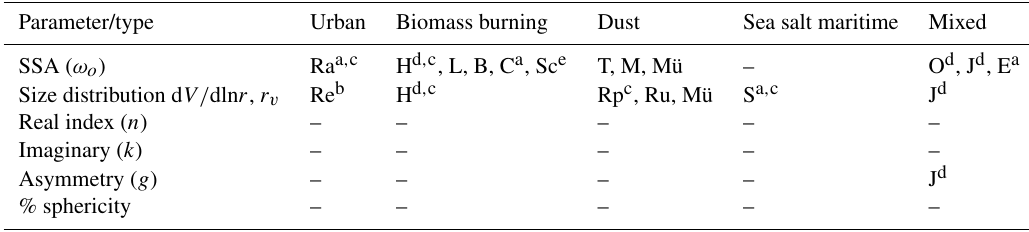
Table 2. The aerosol types detectable from remote-sensing (RS) techniques and compared with in situ field measurements. We show only those direct RS–in-situ comparisons. Unlike Table 1, here the aerosol type describes the properties of the aerosols rather than sources. We acknowledge that aerosol typing is difficult and still subjective and incomplete. (C: Corrigan et al., 2008; E: Esteve et al., 2012; Sc: Schafer et al., 2014, 2017). Some studies appearing below are given in the caption of Table 1. Parameter/type Fine Coarse Mixed Inorganic Organic Mineral Organic NaCl